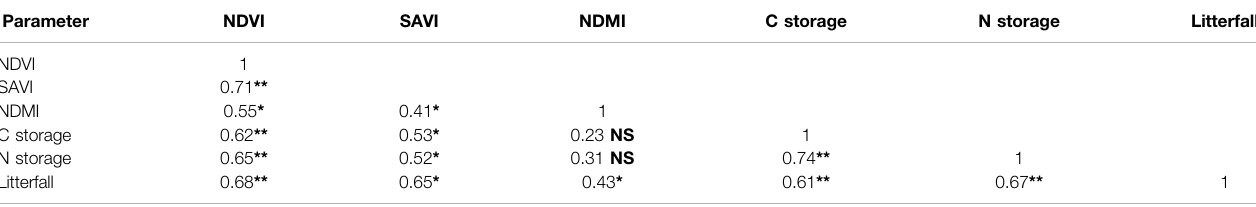
**Correlation is signi fi cant at the 0.01 level (2-tailed). *Correlation is signi fi cant at the 0.05 level (2-tailed). NS , Non-signi fi